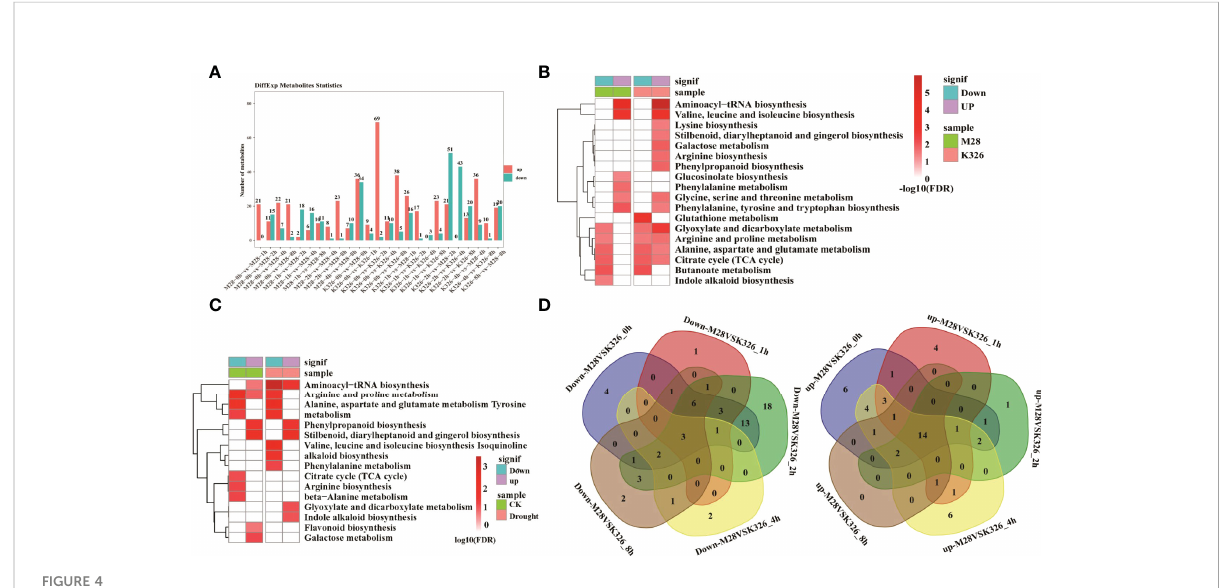
FIGURE 4 Differential metabolic changes in response to drought treatment between M28 and K326. (A) Histogram showing the number of differential metabolic changes in response to time-point-related drought-induced in M28 or K326 or between M28 and K326. (B) KEGG pathway enrichment analyses of up- and down-regulated metabolites in K326 or M28 under drought treatment. (C) KEGG pathway enrichment analyses of metabolites that were up- or down-regulated before (CK) or under drought treatment. (D) Pairwise comparisons of down- (left) and up- regulated (right) metabolites at the same time point between M28 and K326 after drought